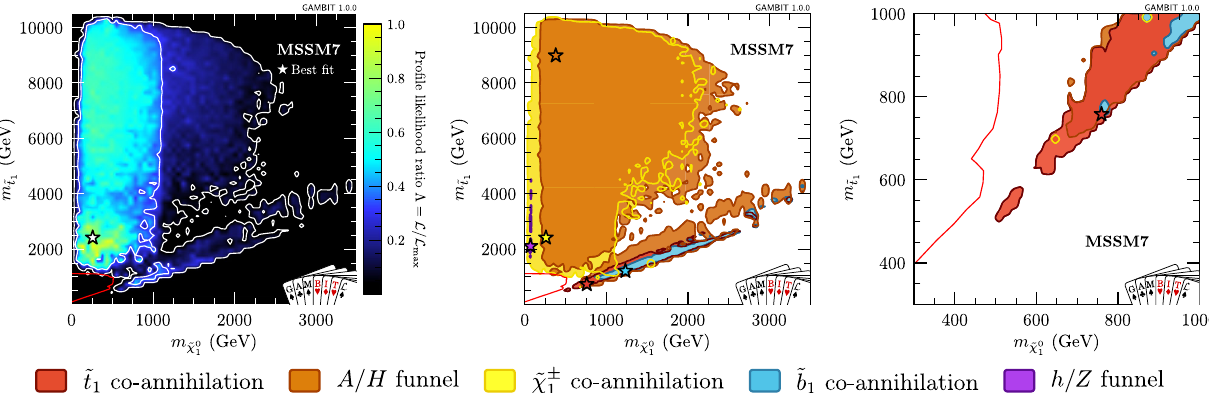
Fig. 11 Left: the profile likelihood ratio in the ˜ t 1 − ˜ χ 0 Centre: colour-coding shows mechanism(s) that allow models within the 95% CL region to avoid exceeding the observed relic density of DM. The regions shown correspond to neutralino co-annihilation with